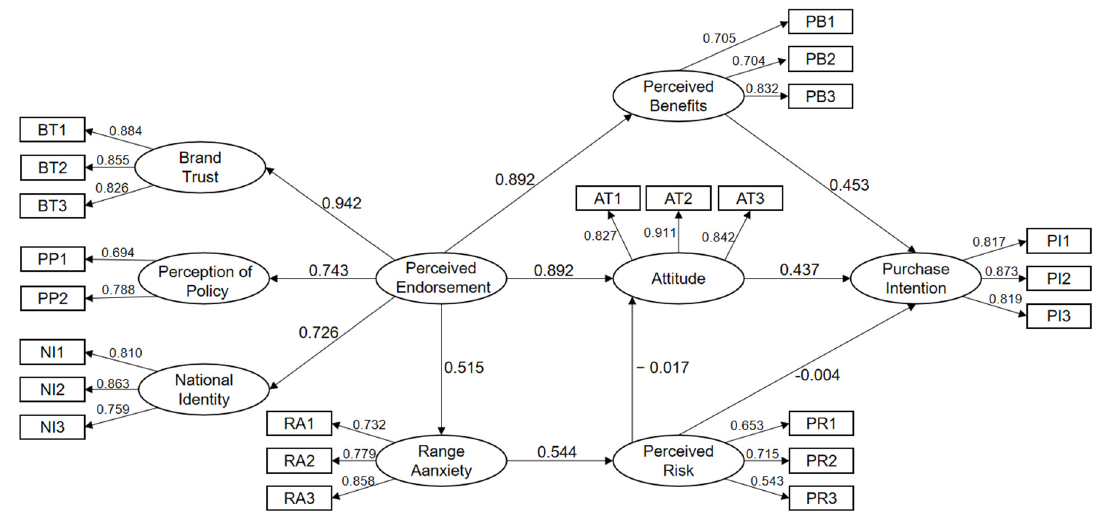
Figure 2. The influence between variables in the structural model. Source: author.